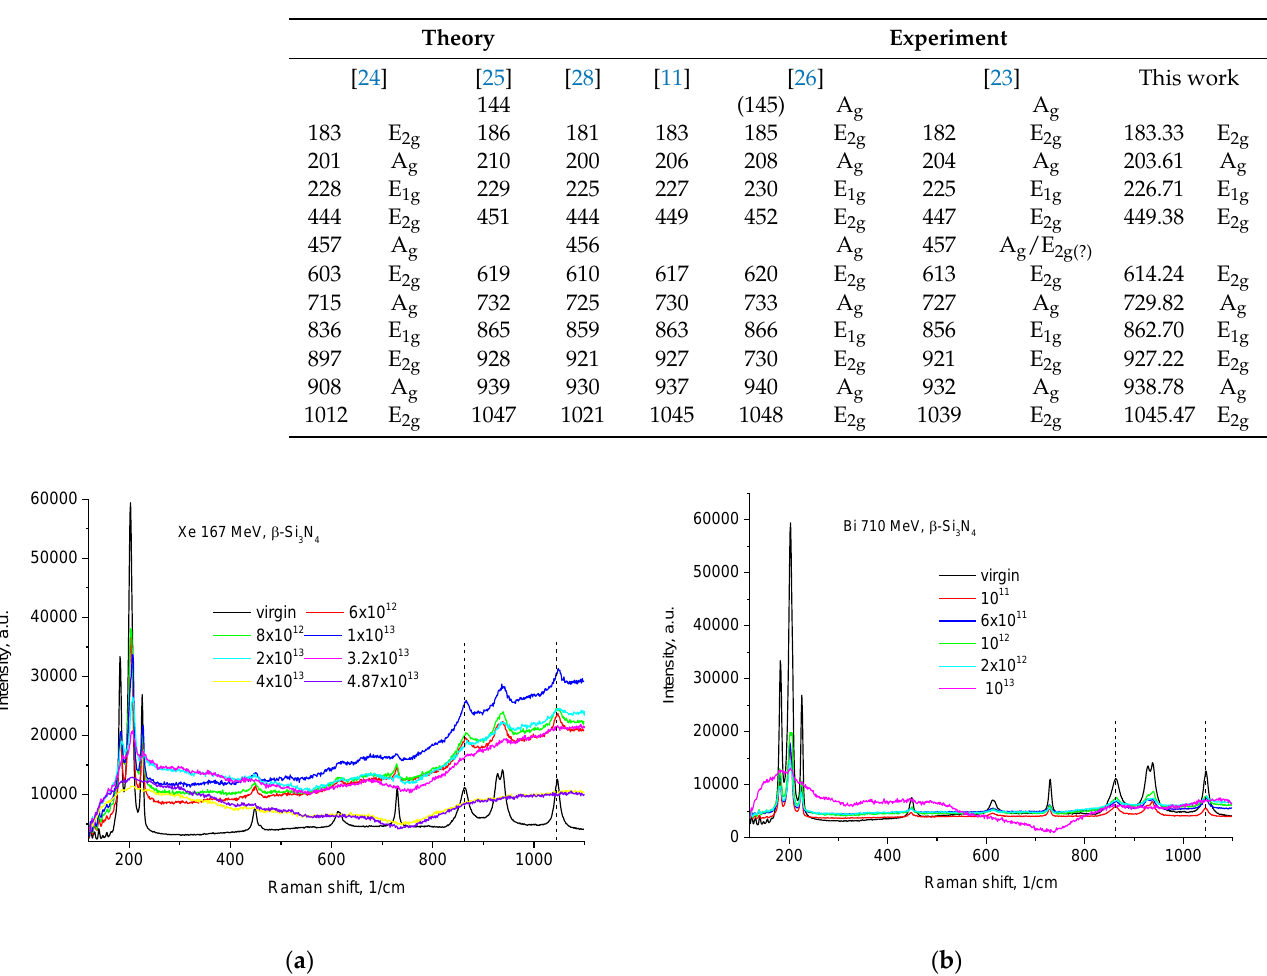
Table 2. Theoretical and experimental parameters of the Raman spectra in β -Si 3 N 4 .